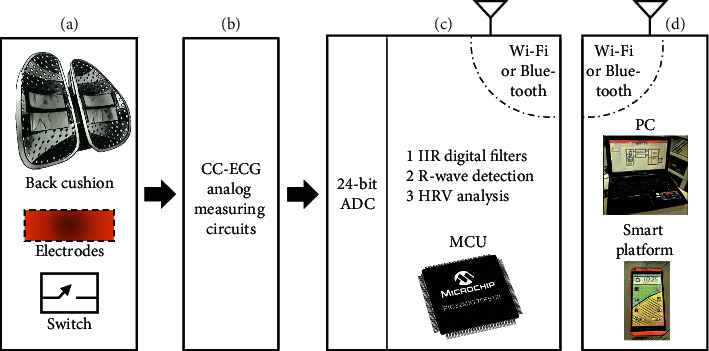
System structure.